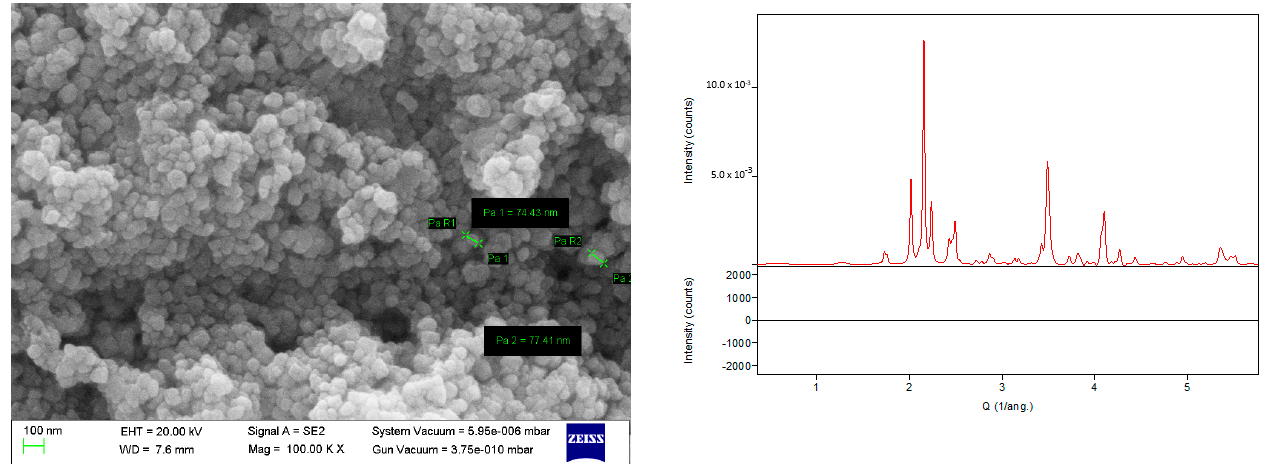
Figure 1. SEM and XRD of a CSZ powder sample with 9 mol% of CaO.